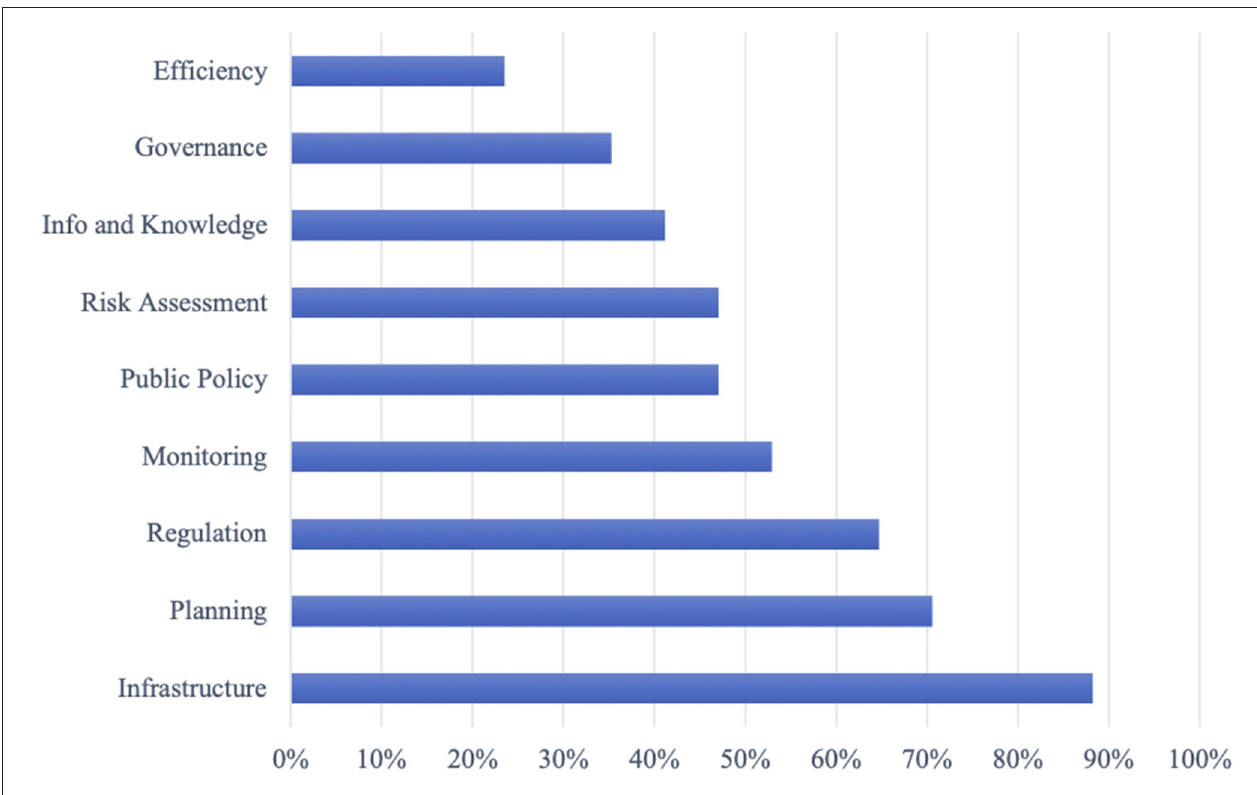
FIGURE 5 | Stakeholder views on integrated areas of water and